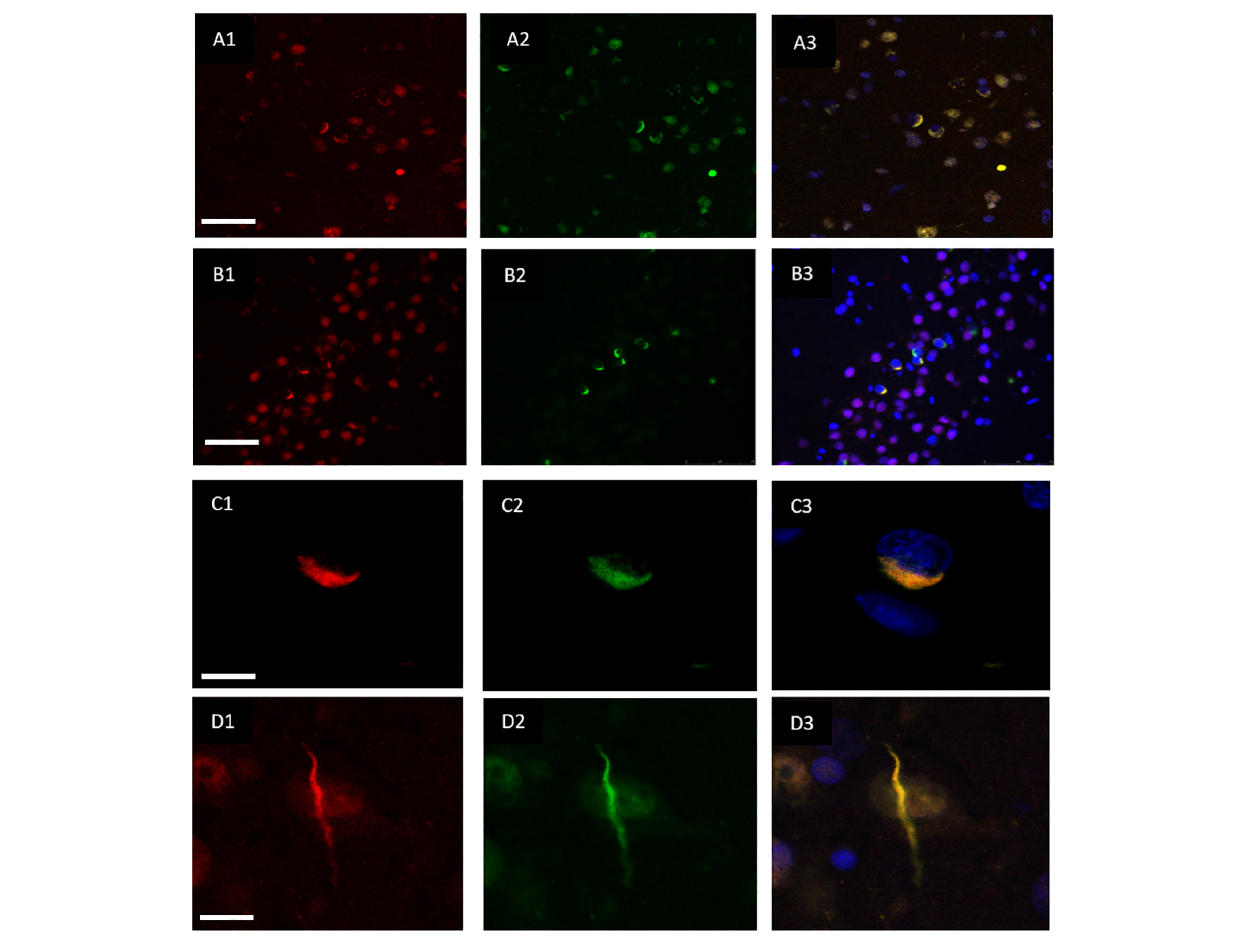
FIGURE 2 | Co-localisation of TDP-43 and hnRNP E2. Double-labeling immunofluorescence shows inclusions positive for TDP-43 (red) (A1) and hnRNP E2 (green) (A2) in the frontal cortex of a subtype A case, the merged image (A3) shows numerous areas of co-localisation (case ID BBN_15298). Co-localisation is also seen in the hippocampus, panels (B1–B3) show a subtype A case (case ID 482 BBN_4568). Higher magnification images demonstrate the complete co-localisation of the TDP-43 and hnRNP E2 in a perinuclear inclusion from the subtype A case (C1–C3) and along a dystrophic neurite in a subtype C case (D1–D3) (case ID BBN_15303). Scale bar represents 100 µ m in panels (A1–A3,B1–B3) , 25 µ m in panels (C1–C3,D1–D3)